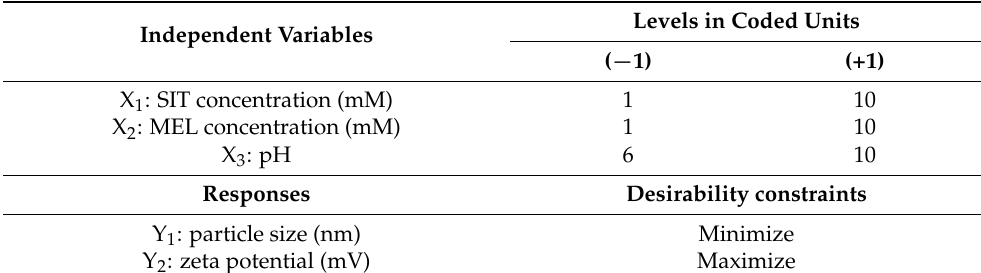
Table 1. Independent variables and responses of SIT-MEL nano-sized systems used in 2 3 full factorial